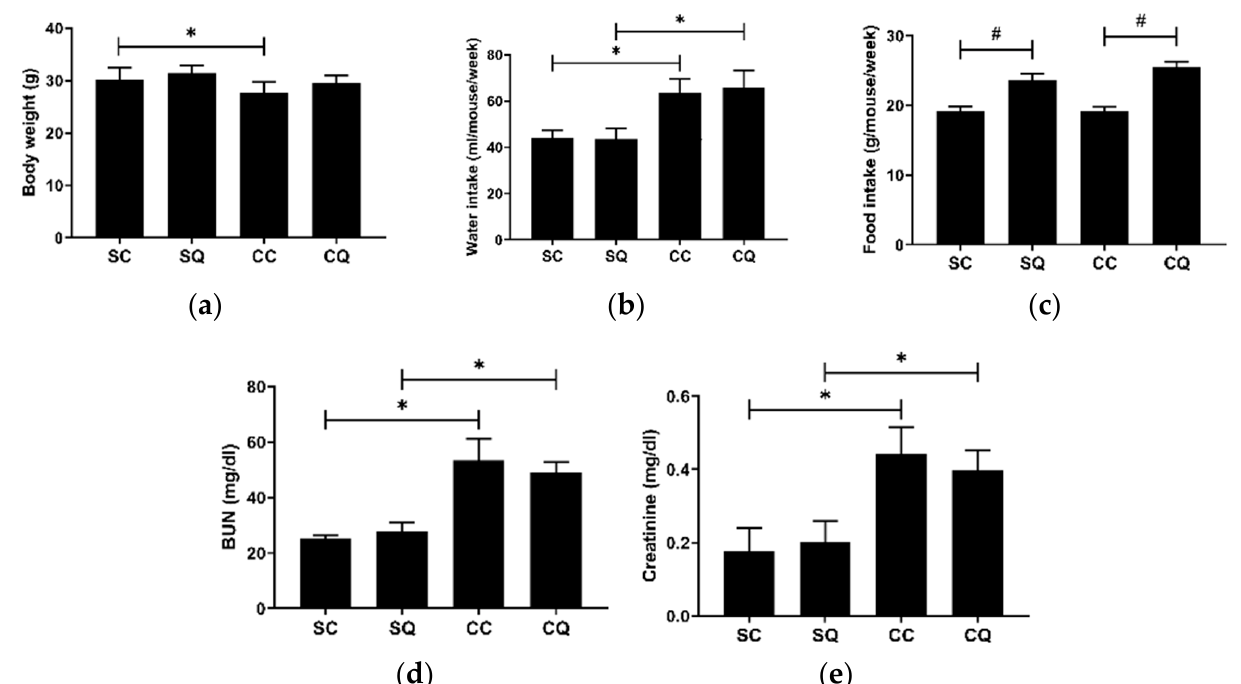
Figure 2. ( a ) Body weight, ( b ) water intake, ( c ) food intake, ( d ) BUN level and ( e ) creatinine level in the sham surgery and CKD surgery mice treated with vehicle (corn oil) or CoQ10. SC: sham surgery mice with vehicle; SQ: sham surgery mice with CoQ10; CC: CKD surgery mice with vehicle; CQ: CKD surgery mice with CoQ10. Data are expressed as the mean ± SD ( n = 9 per group). * p < 0.05 denotes a significant difference between the sham surgery and CKD surgery groups (SC vs. CC and SQ vs. CQ); # p < 0.05 denotes a significant difference between the vehicle treatment and CoQ10 treatment groups (SC vs. SQ and CC vs. CQ). CoQ10, coenzyme Q10.